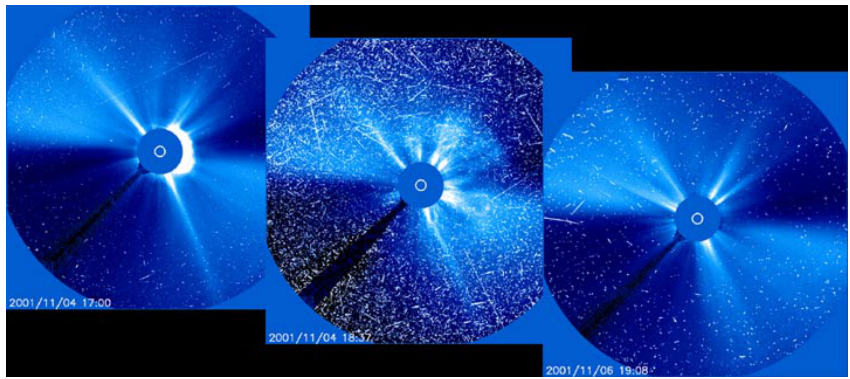
Fig. 3. SOHO has advanced our knowledge of space weather. This series of images from the LASCO coronagraph shows the launch of a CME on the right of the Sun, followed 90min later by the arrival of solar protons (indicated by the “snowstorm” effect in the middle image). Image courtesy